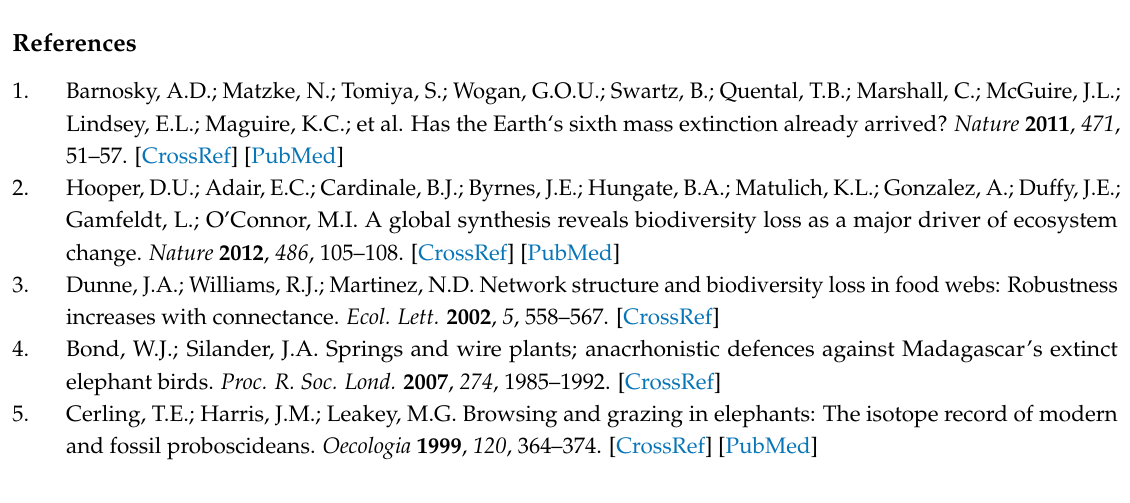
Table S1: Stable isotope and radiocarbon data for individual specimens included in this study, Table S2: Published data for foliage from modern C 3 plants and expected δ 13 C and δ 15 N values for herbivores and faunivores that consume C 3 plants in each biome, Table S3: 95% and 50% confidence interval estimates for last occurrences for Canariomys bravoi and Gallotia goliath